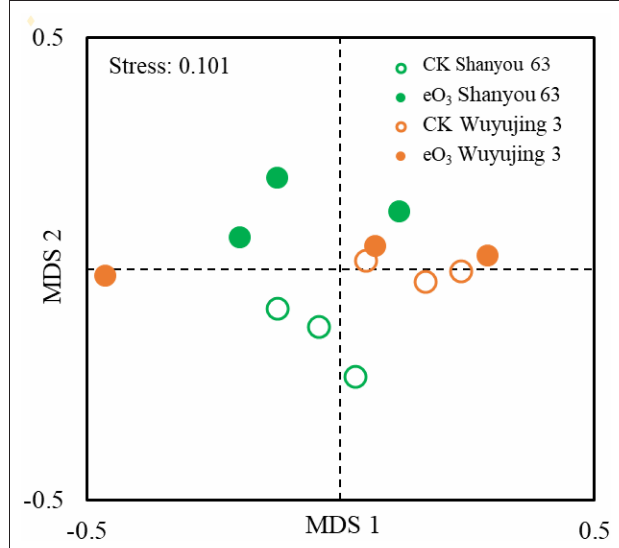
FIGURE 1 | Non-multidimensional scaling (NMDS) analysis of the nematode community under elevated ozone.